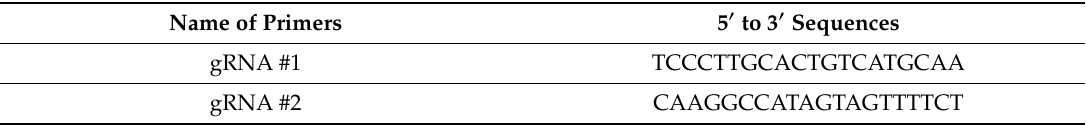
Table 1. The sequence of gRNA.